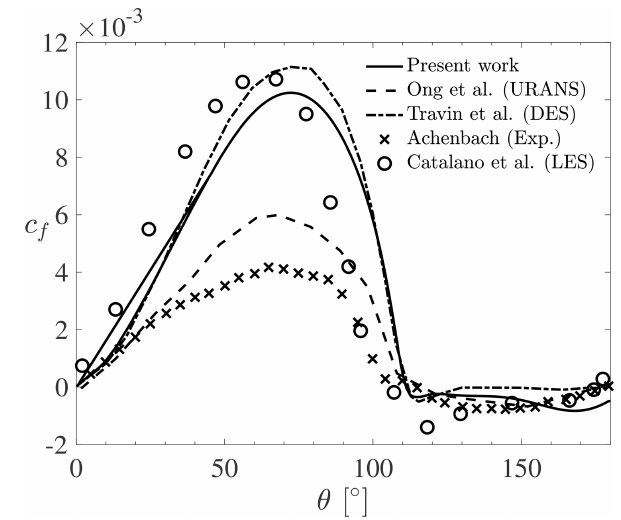
Figure 7. Time-averaged friction coefficient for flow past a station- ary cylinder in the supercritical turbulent